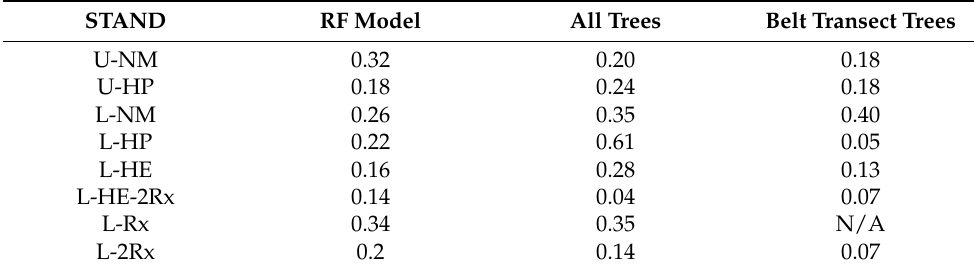
Table 8. Proportion of LOW trees in each stand type as determined by the Random Forest model using spectral data (RF model), field qualitative assessment of the belt transect trees ( n = 108) and 298 additional trees (All trees), and field qualitative assessment of 30 trees in a belt transect (Belt transect trees). Stand codes are L = lowland; U = upland; HP = harvested, patchy; HE = harvested, even spacing; NM = no management, Rx = prescribed burn. N/A indicates that no belt transects were conducted in this stand. STAND RF Model All Trees Belt Transect Trees U-NM 0.32 0.20 0.18 U-HP 0.18 0.24 0.18 L-NM 0.26 0.35 0.40 L-HP 0.22 0.61 0.05 L-HE 0.16 0.28 0.13 L-HE-2Rx 0.14 0.04 0.07 L-Rx 0.34 0.35 N/A L-2Rx 0.2 0.14